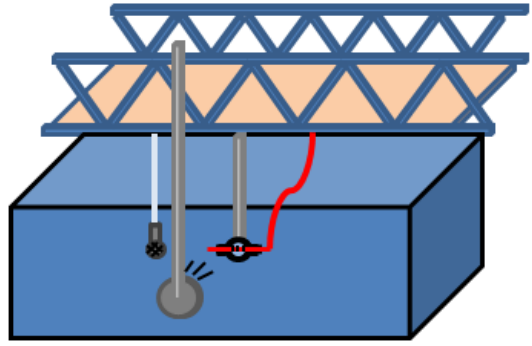
Figure 7. Experimental platform by using the FBG hydrophone and the standard piezoelectric hydrophone. A frequency transducer (TR-208A) is used to generate the acoustic wave with the frequency of 4 kHz and 6 pulses per signal package. From Figure 8, the top blue signal is the original output signal from the generator to be output to drive the transducer (TR- 208A), the middle black signal is the acoustic wave measured by the standard hydrophone (8103, B&K), and the bottom signal is the acoustic wave detected by the FBG hydrophone. From the comparison of these experimental results, we can see that the proposed FBG hydrophone has better sensitivity than that of the standard piezoelectric hydrophone. For detecting the original acoustic wave of 6 pulses, there are 20 pulses to be measured by the two hydrophones. This is because the echo caused by the acoustic wave is reflected back to the hydrophone.